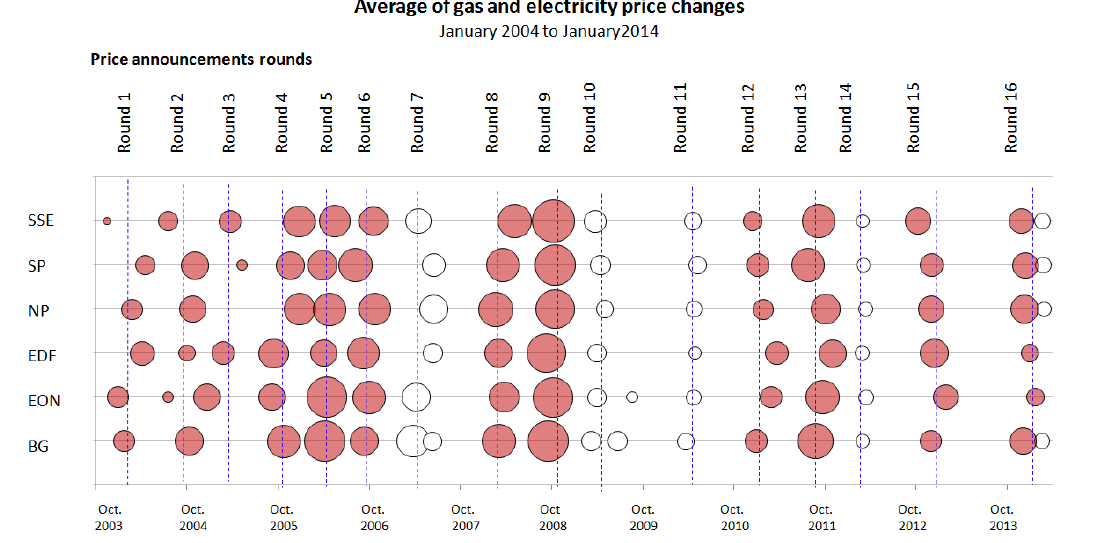
Source: Analysis of public price announcements by the six largest